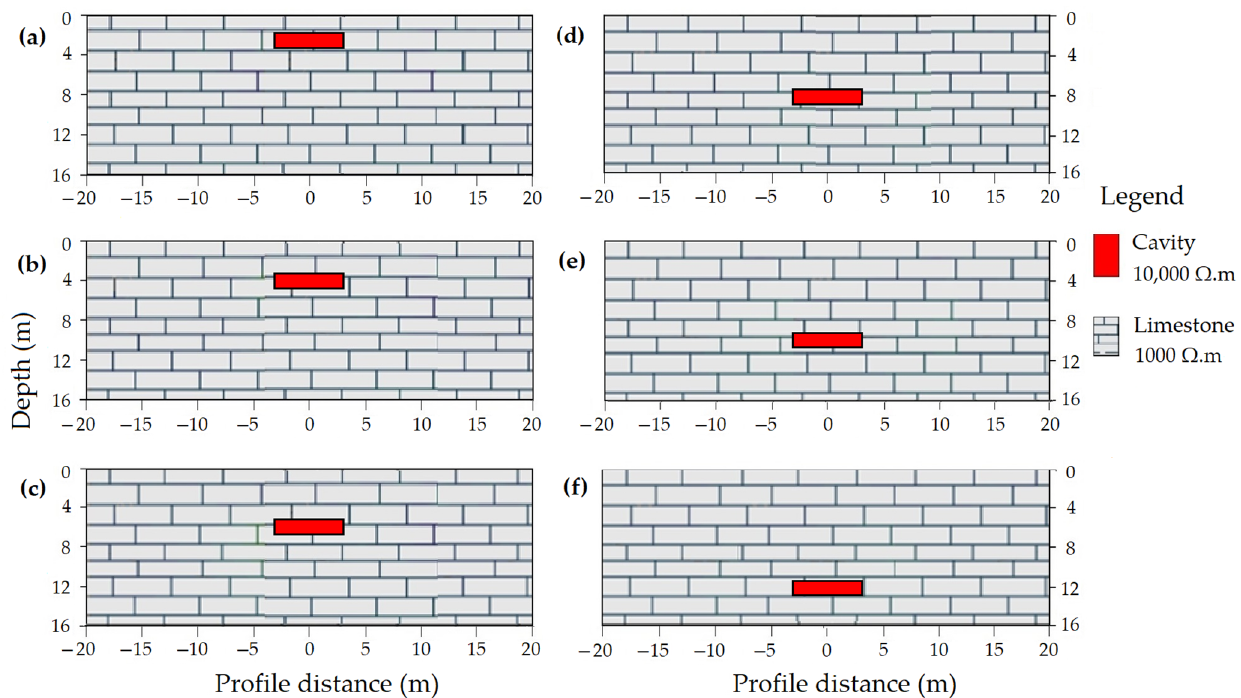
Figure 1. Resistivity synthetic models that represent a target cavity set in limestone unit at six different depths: ( a ) Target cavity T 1 at 2.2 m, ( b ) target cavity T 2 at 4.2 m, ( c ) target cavity T 3 at 6.2 m, ( d ) target cavity T 4 at 8.2 m, ( e ) target cavity T 5 at 10.2 m, ( f ) target cavity T 6 at 12.2 m depth. The depth indicates the mid-point of the cavity. For better illustration, we presented only 40 m horizontal section of the models.